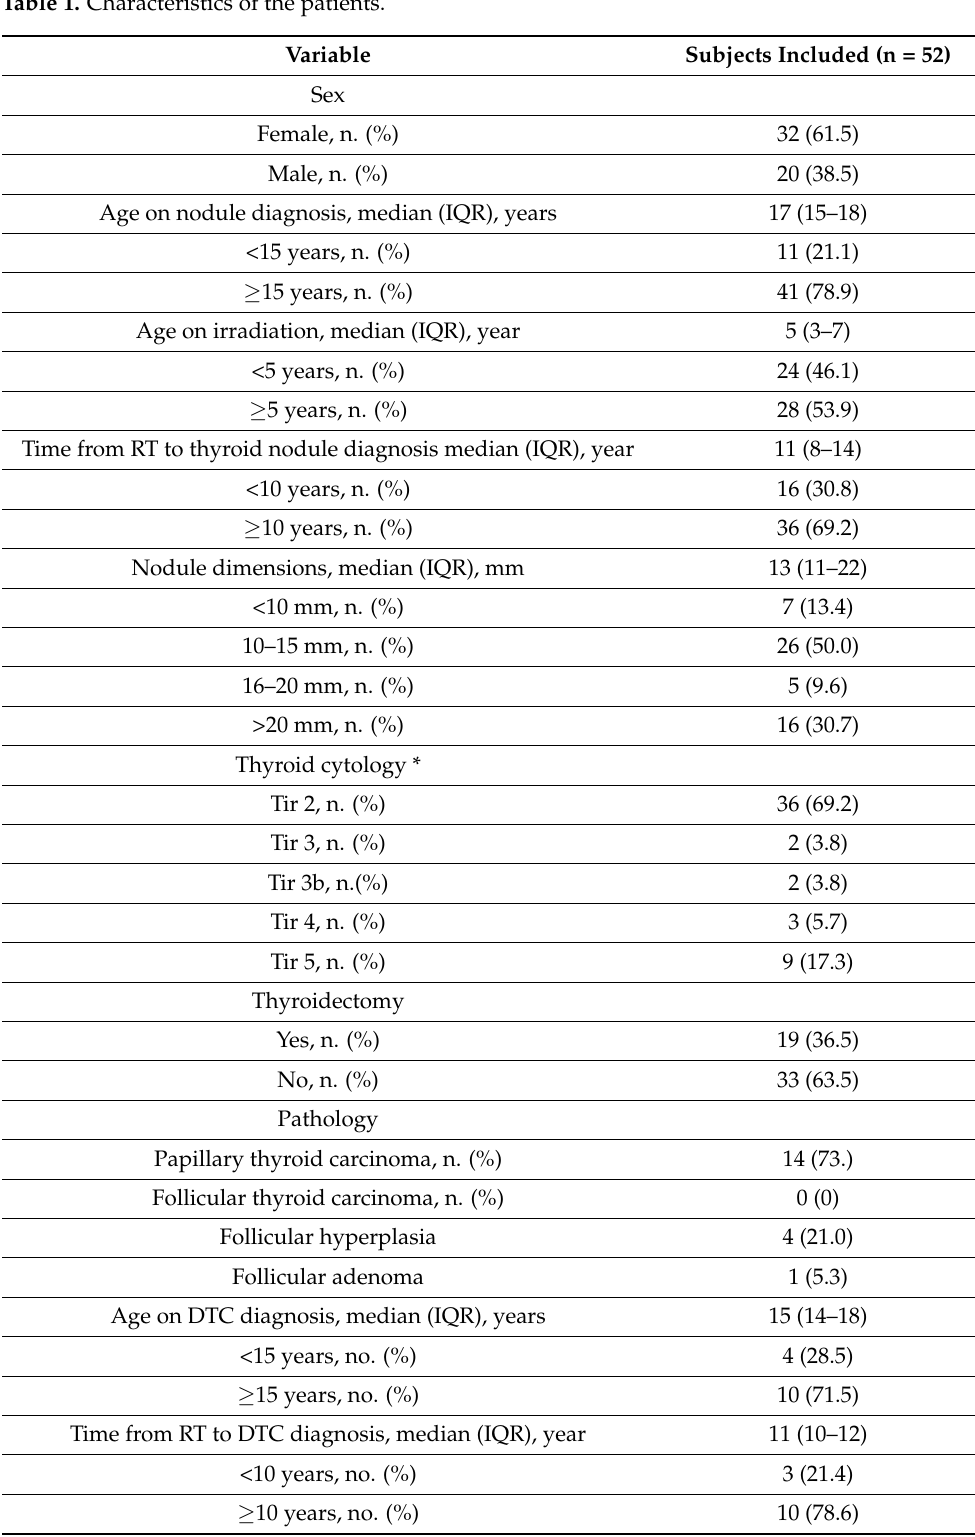
Table 1. Characteristics of the